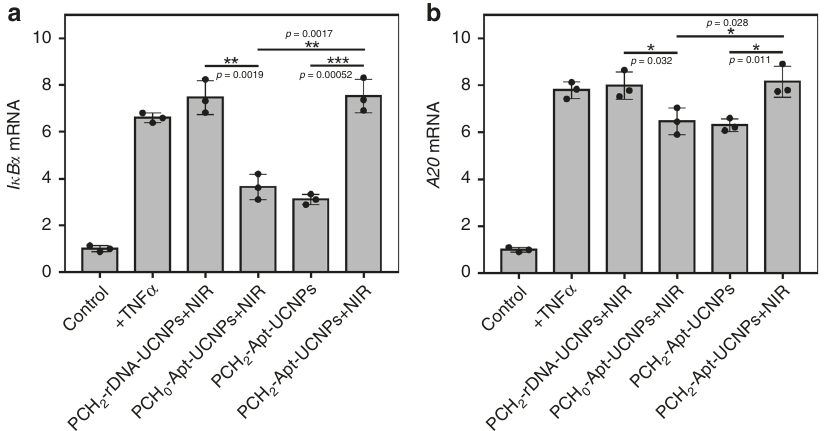
Fig. 5 NIR-responsive manipulation of native RelA localization-related genetic program. Q-RT-PCR analysis of I κ B α mRNA expression a and A20 mRNA expression b after A549 cells were processed with different treatments. Except for the control (untreated) sample, all other samples were stimulated with TNF α . NIR laser irradiation time was fi xed at 30 min. The experimental data were normalized using the GAPDH as an internal reference. Relative expression of these two mRNAs was calculated by setting the corresponding value of the control sample as 1. All data were collected from three independent experiments and presented as mean values ± S.D. * P ≤ 0.05, ** P ≤ 0.01, *** P ≤ 0.001 by two-tailed unpaired Student ’ s t